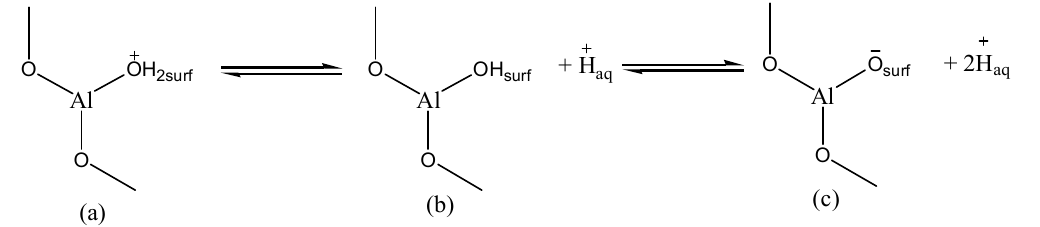
Figure 7. Properties of γ ANPs.surface: ( a ) acidic pH, positive charge; ( b ) point of zero charge; ( c ) basic pH, negative charge.